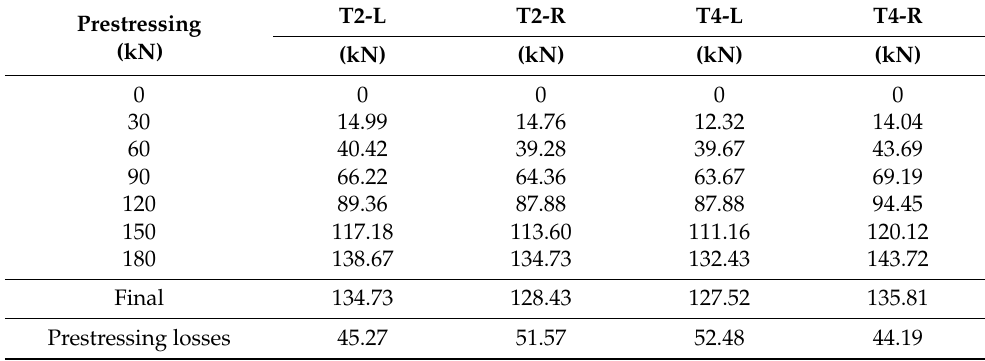
Table 4. Prestressing of strands T2 and T4.